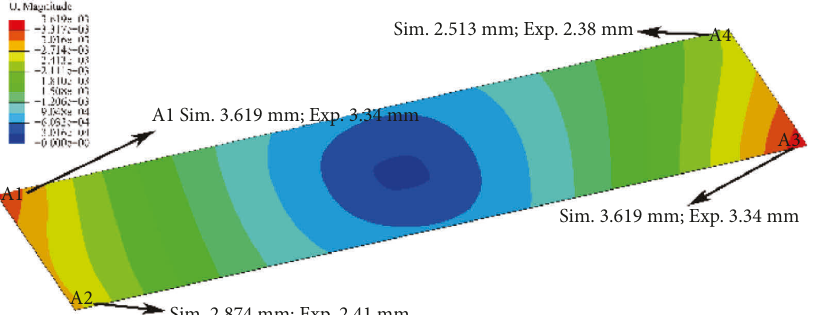
Figure 11: Curing deformation of the panel under a uniform temperature field.